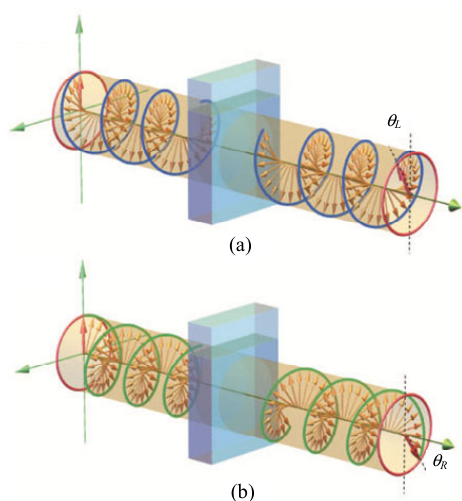
Fig. 1 Schematic illustrating the change of beam polarization: (a) when the light goes through the right-handed solution, its left-handed polarization changes a comparatively small angle and (b) when the light goes through the right-handed solution, its right-handed polarization changes a bigger